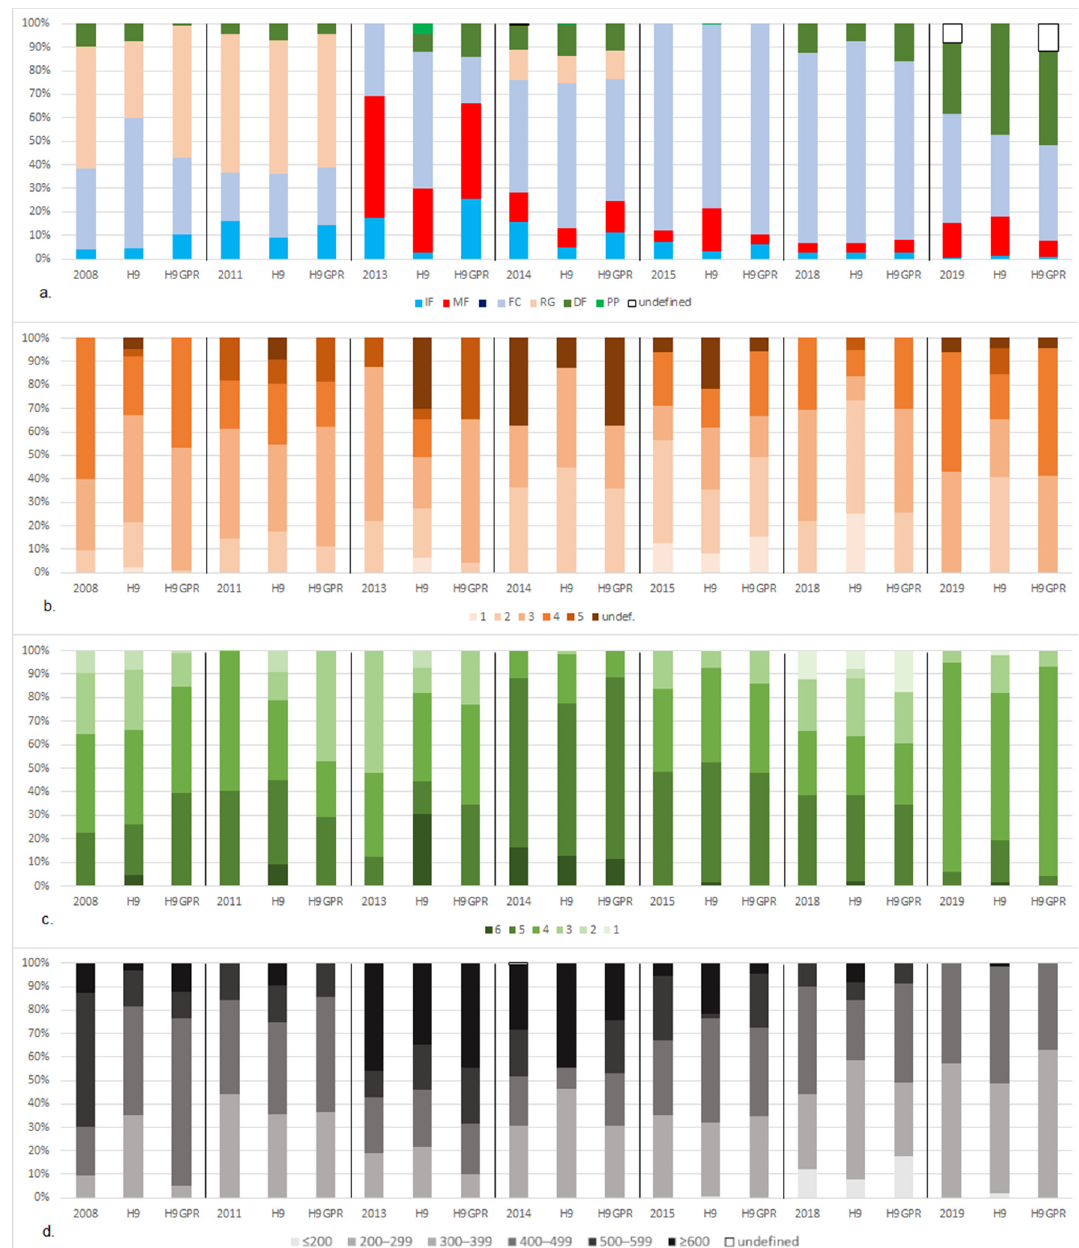
Figure 9. Percentage contribution of grain shape ( a ), size ( b ), hardness ( c ) and density ( d ) classes in 2008–2019. Bars marked H9 show the percentage of individual snow parameters in the snow pit. H9GPR bars represent the average value of individual parameters from 40 traces up and down from the location of the snow pit.